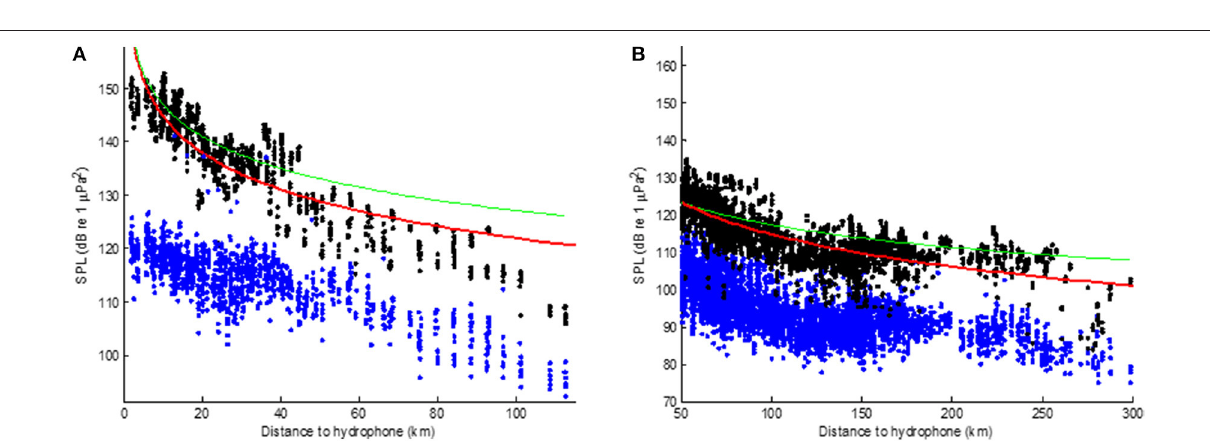
FIGURE 5 | Logarithmic fit on the sound levels of the third octave band centered on 40 Hz for measurements up to 150 km away using data from hours 860 to 990 (A) and measurements between 50 and 300 km away (B) from the Greenland I recorder. Level measurements are in black; background noise measurements are in blue. The green line represents spherical loss; the red line is a logarithmic fit. The optimal fit up to 50 km range (A) has parameters –16 log 10 (R) (residual RMS = 4.2 dB) and beyond 50 km (B) –29 log 10 (R) (residual RMS = 4.6